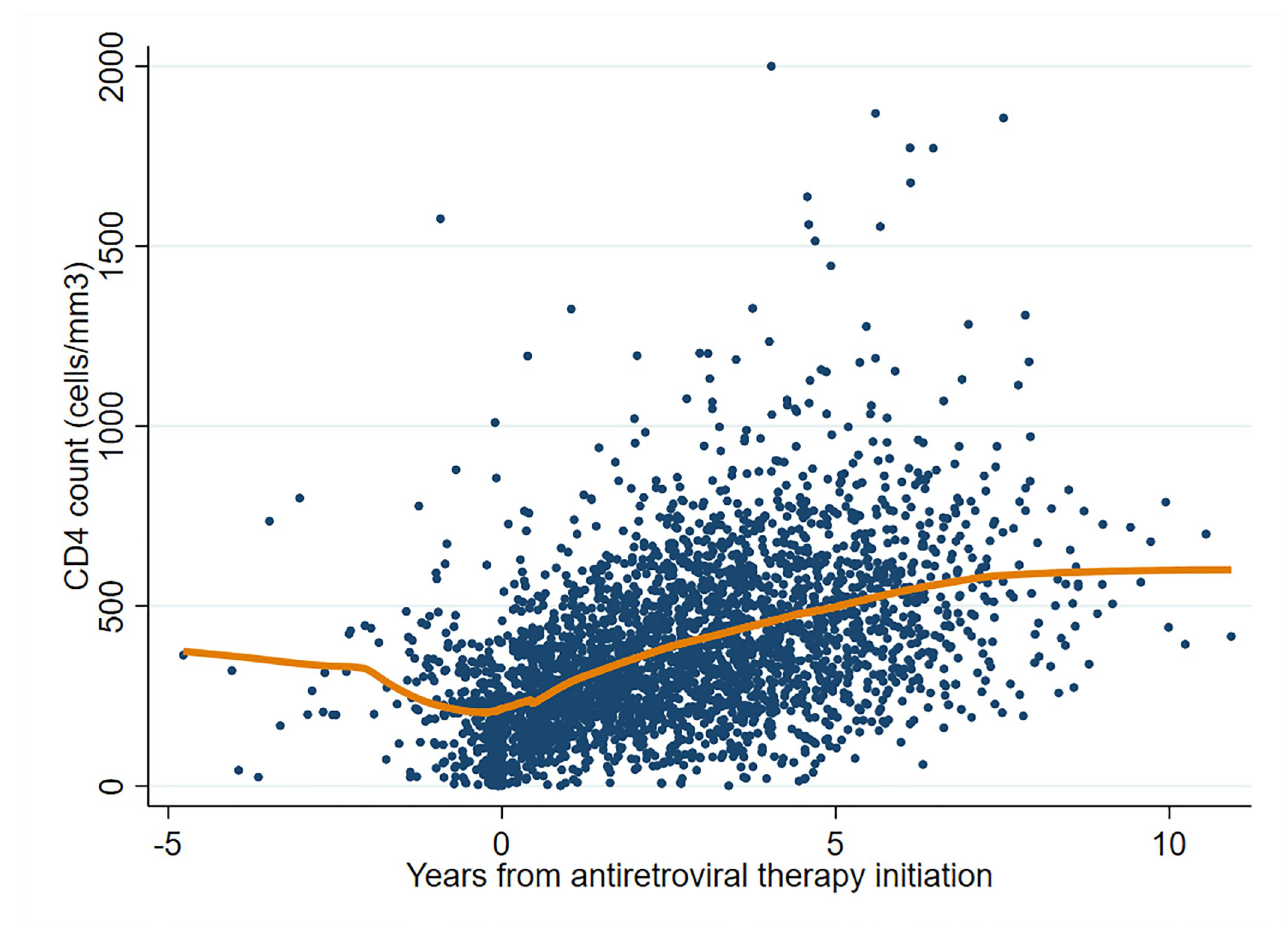
Fig 3. CD4 count trends from time of ART initiation among a cohort of HIV-infected individuals on ART in Tanzania.